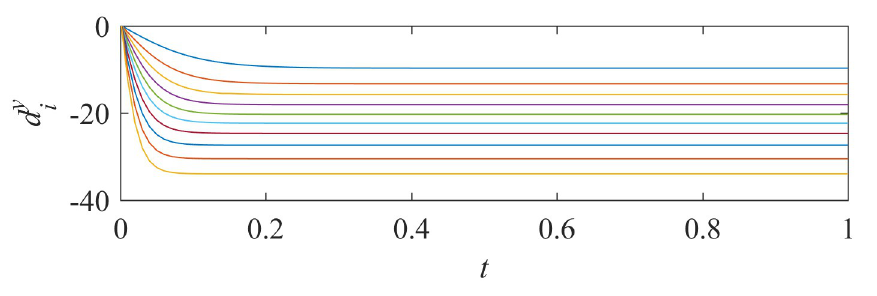
Fig 4. Trajectory of adaptive laws of sub-network Y (Eq (4)).